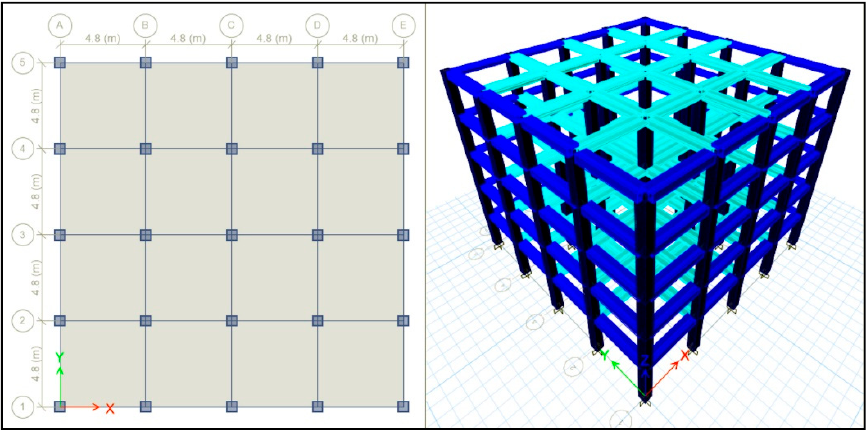
Figure 1. Building plan ( left ); numerical model ( right )